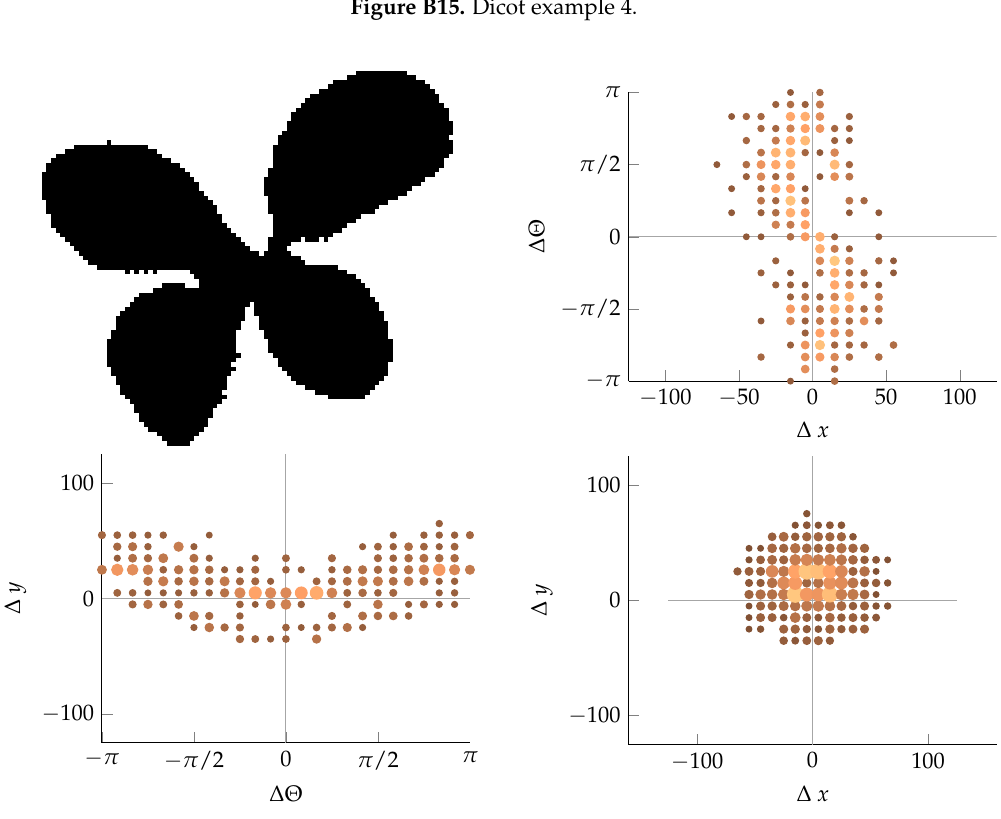
Figure B15. Dicot example 4.